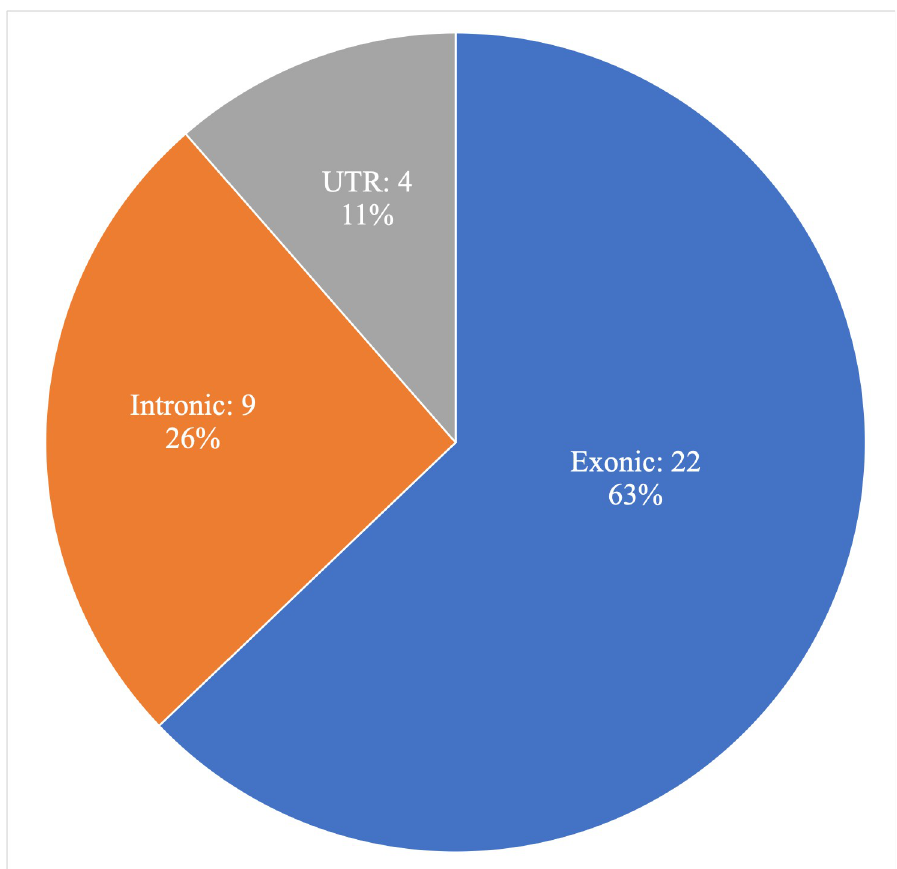
Fig 3. Investigated variants in different genomic